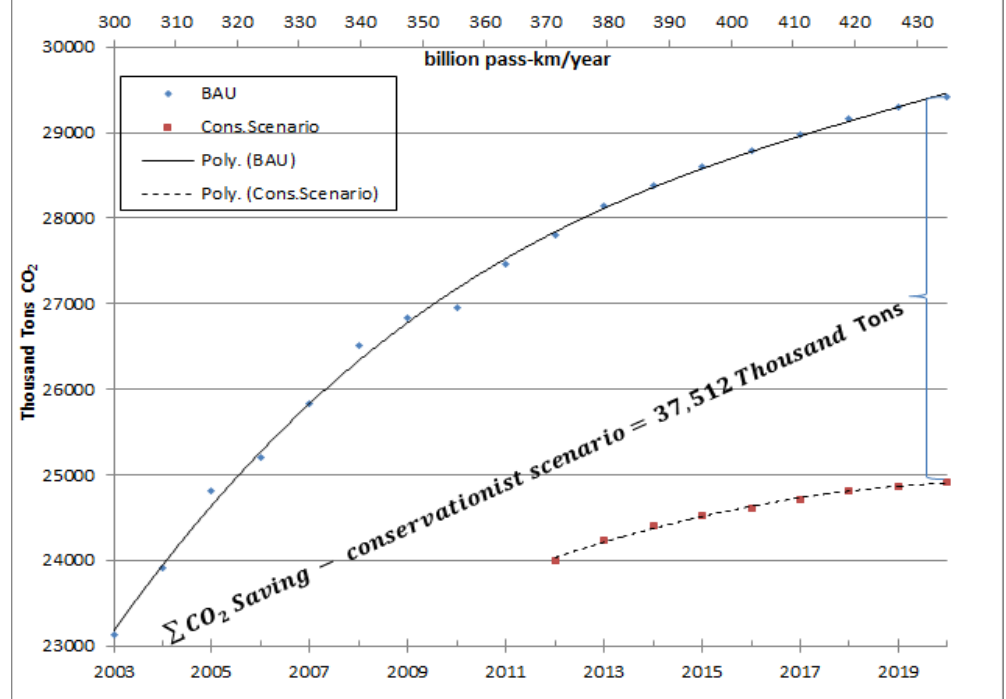
Figure 11. CO Emissions Trends—2012/2020. 2